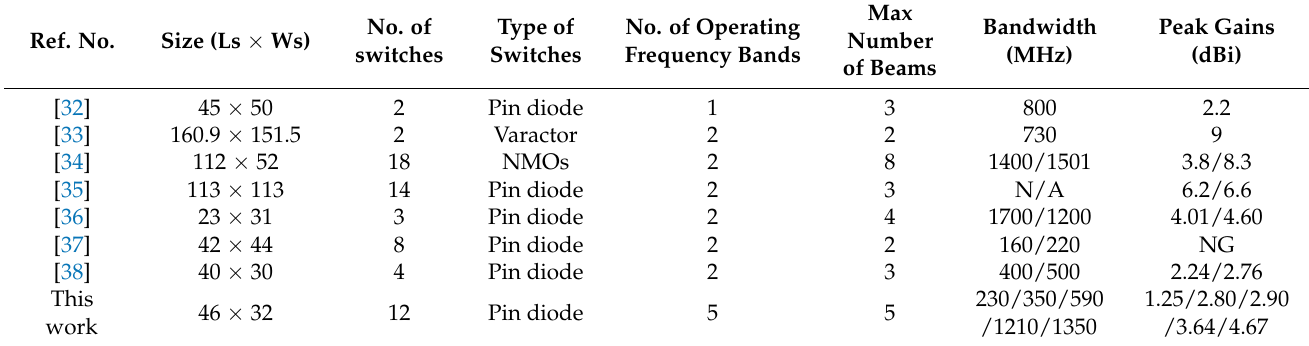
Table 4. Comparison of the performance of the proposed antenna with other relevant designs.